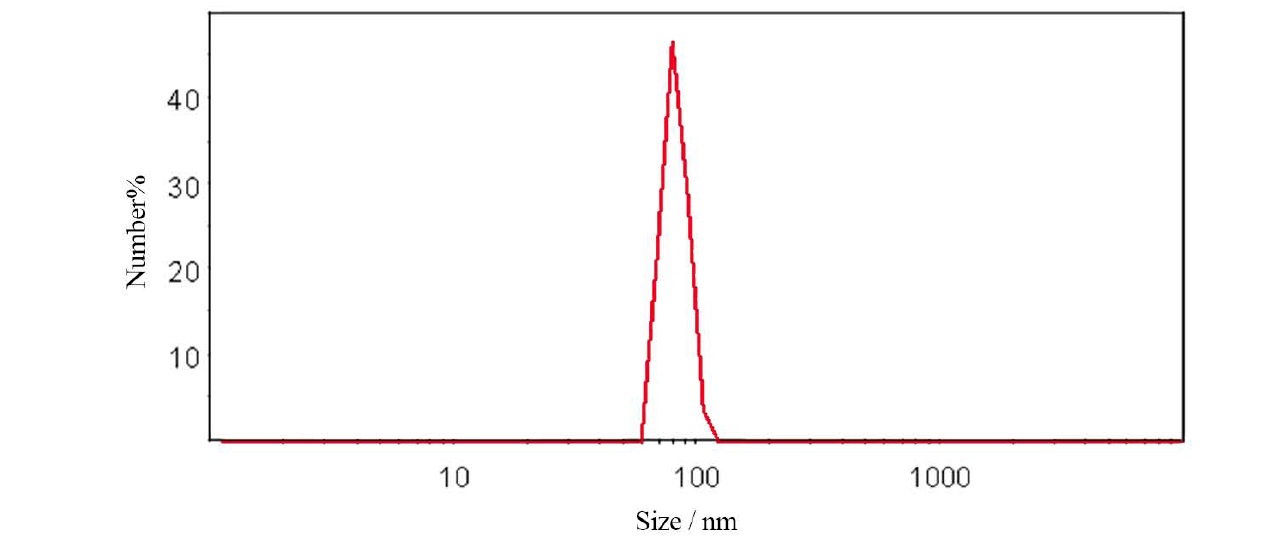
Figure 1 - Dependency of absorbance values on the imatinib concentrations dissolved in tween 80 (A), PEG 600 (B) and ethyl oleate (C) at room temperature. The data was obtained for evaluation of the imatinib solubility in each